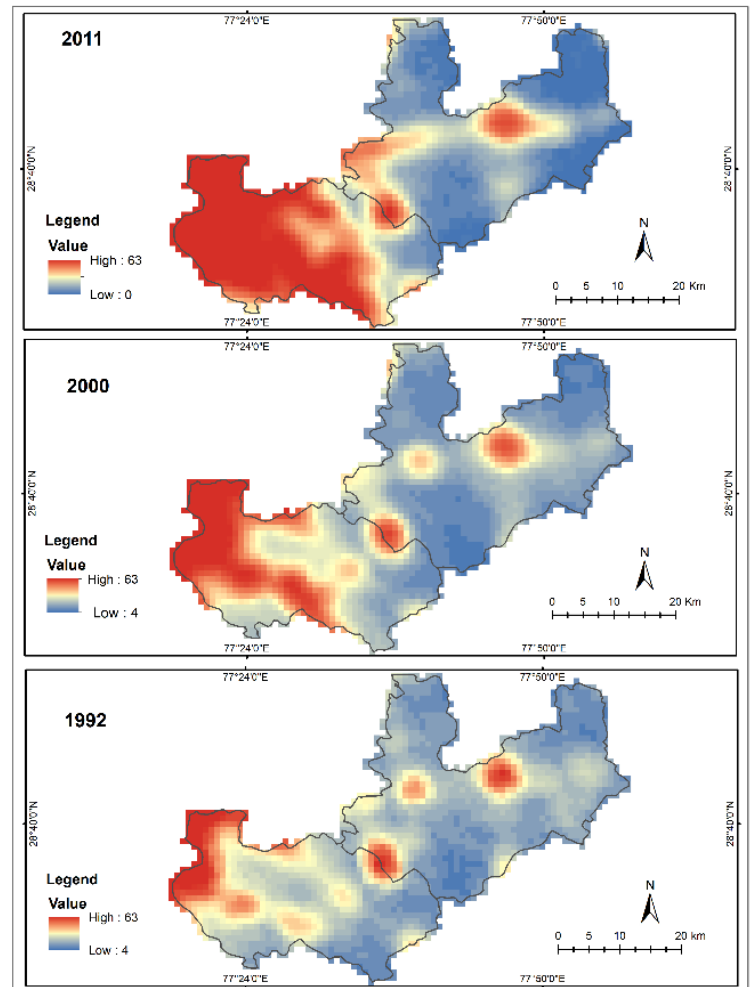
Figure 8. Defense Meteorological Satellite Program-Operational Linescan System (DMSP-OLS) nighttime lights data for 1992, 2000, and 2011.